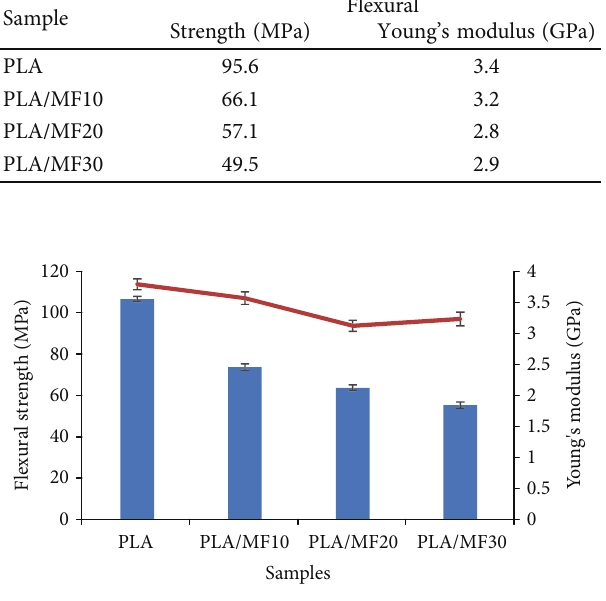
Figure 9: fl exural strength and the fl exural modulus of PLA/MF composites.